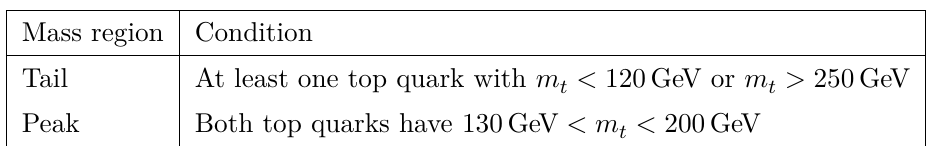
of the two top-quark t